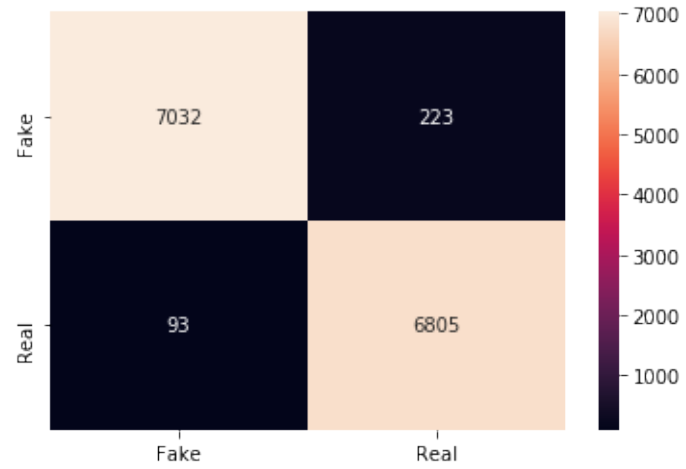
Figure 21. CNN with GlobalMaxpool confusion matrix. The training and loss graphs are visualized in Figures 22 and 23, as follows.